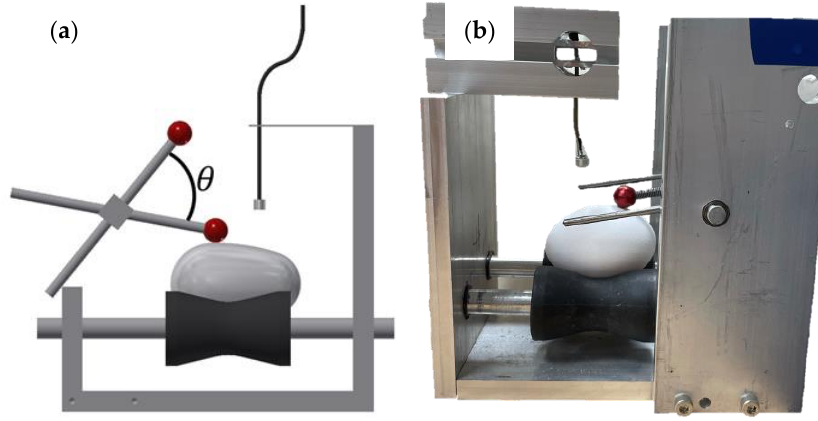
Figure 2. Percussion rod action device ( a ) schematic diagram ( b ) actual device.